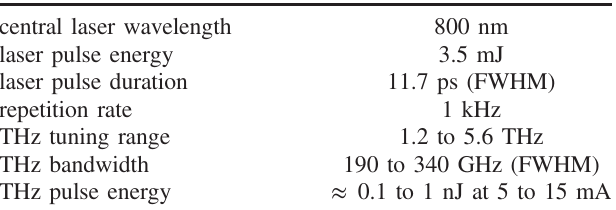
TABLE III. Parameters of the seed laser and narrowband THz pulses generated at DELTA. See text for